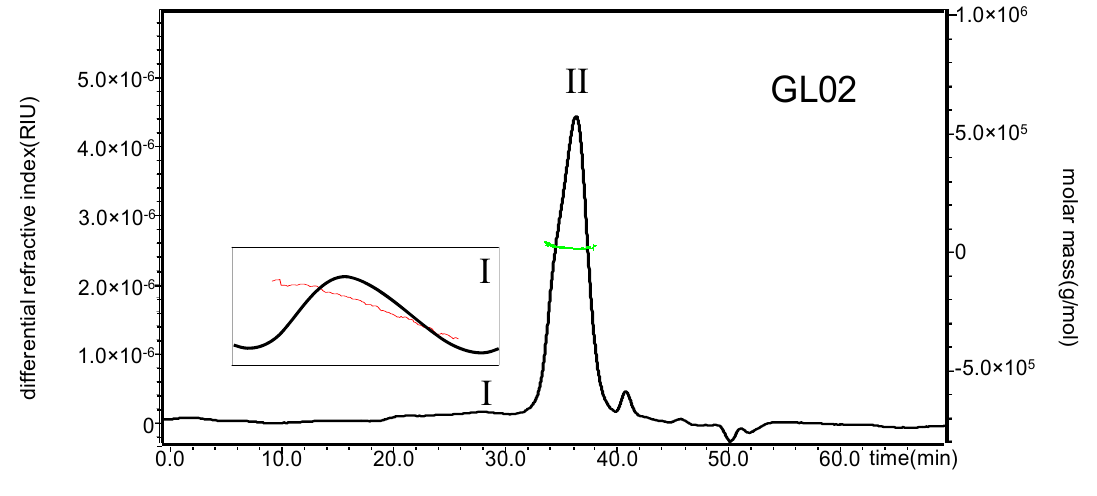
Figure 2. HPSEC-RI profiles with molecular weight distribution of polysaccharides from typical samples of G. lucidum (GL02) and G. sinense